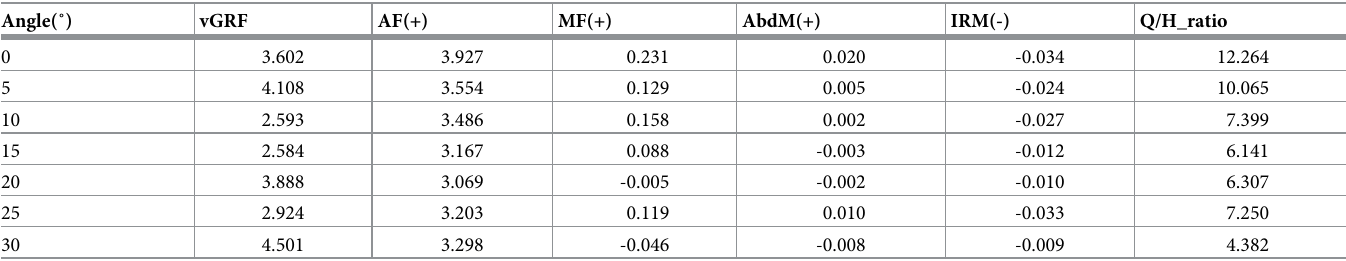
Table 4. Vertical GRF, knee JRF and JRM and Q/H force ratio at peak vGRF time instance for various hip external rotation angles.